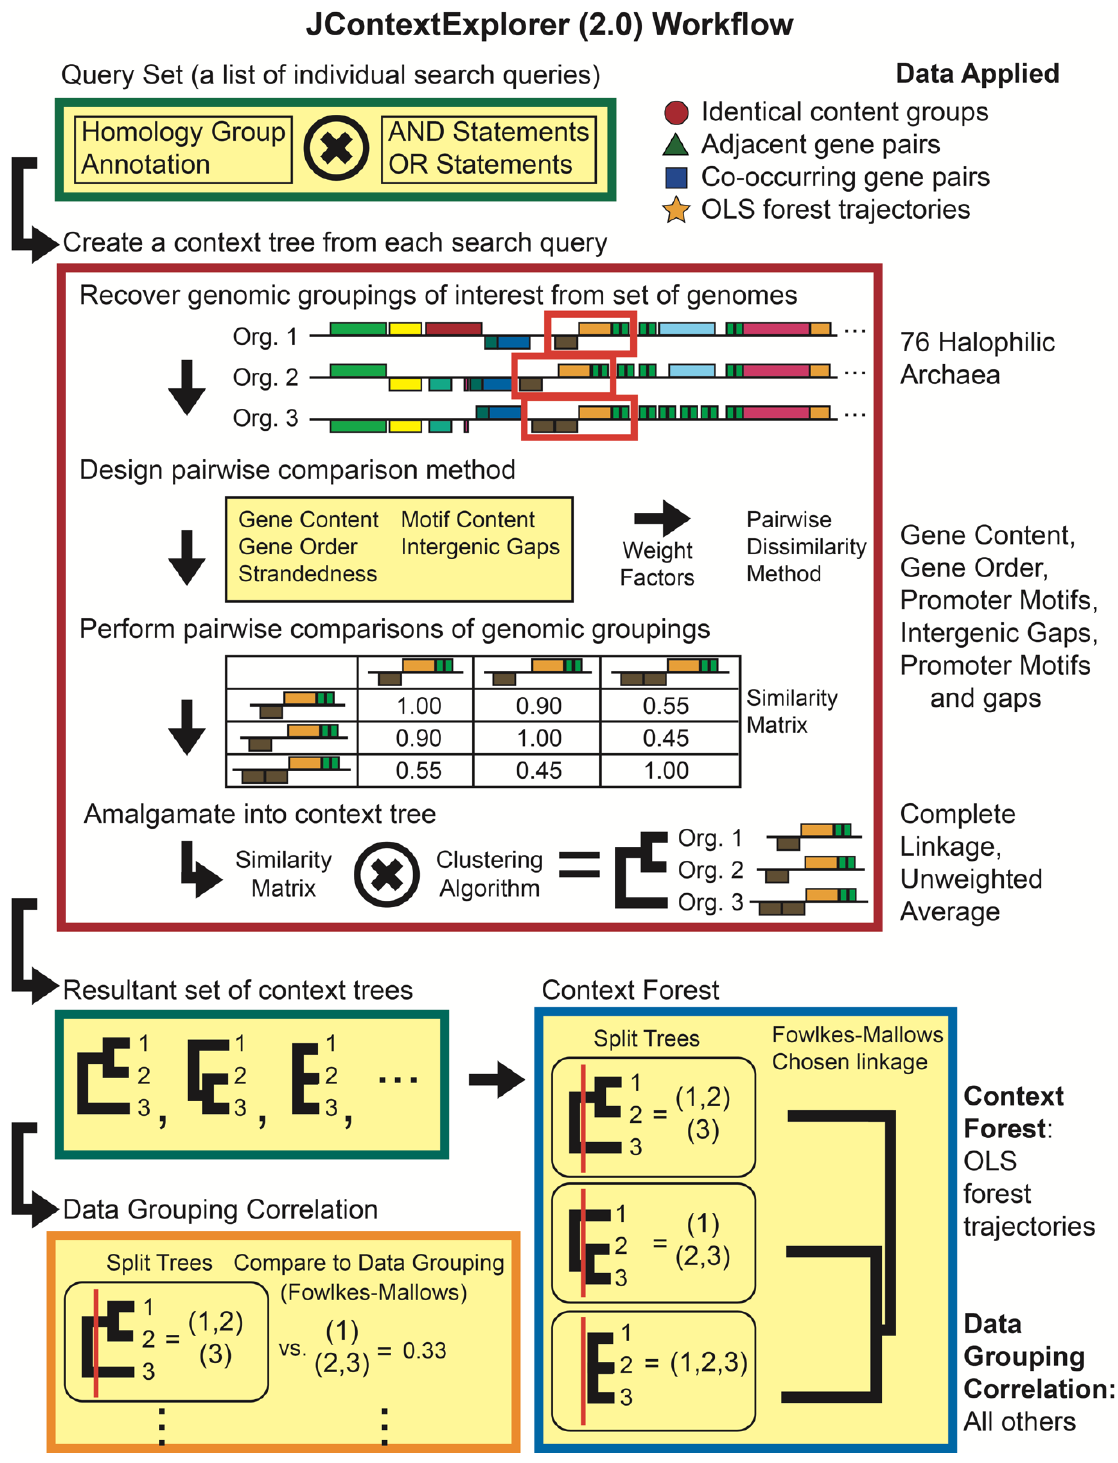
Figure 3. JContextExplorer 2.0 workflow and its application to 76 haloarchaeal species. The previously described JContextExplorer workflow (red box, for detailed description please see [36] and File S3) was extended to allow for the generation of a large set of context trees, which could then be correlated with external data (data grouping correlation, orange box), or to each other (context forest, blue box). In the figure, all boxes with yellow background represent additions to the original algorithm (note the addition of novel comparison metrics, yellow box within red box). The updated approach was applied to a dataset of 76 haloarchaeal species in various ways to determine the degree to which various types of OLS evolution had occurred (textual descriptions at right describe applications of the tool).